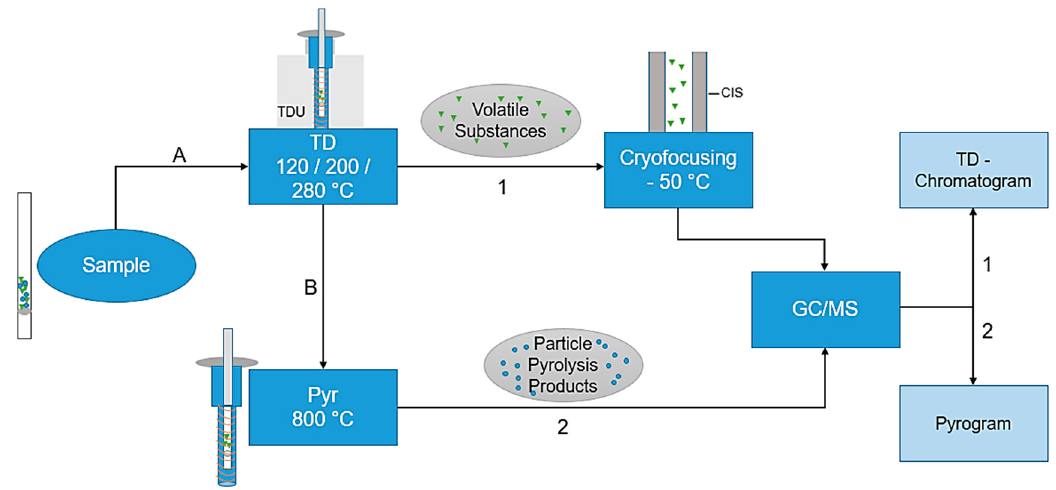
Figure 1. Flowchart of the thermodesorption- and pyrolysis-gas chromatography/mass spectrometry (TD-Pyr-GC/MS) analysis. First, (A) the sample is thermodesorbed (120–280 °C), thereby desorbing the volatile substances and cryofocusing them in the Cooled Injections System (CIS) at − 50 °C. This is followed by a transfer to the GC column with an MS analysis (TD-GC/MS). The same sample (B) is subsequently pyrolyzed at 800 °C, followed by a GC/MS analysis (Pyr-GC/MS). The evaluations are carried out using the TD-Chromatogram and the Pyrogram.